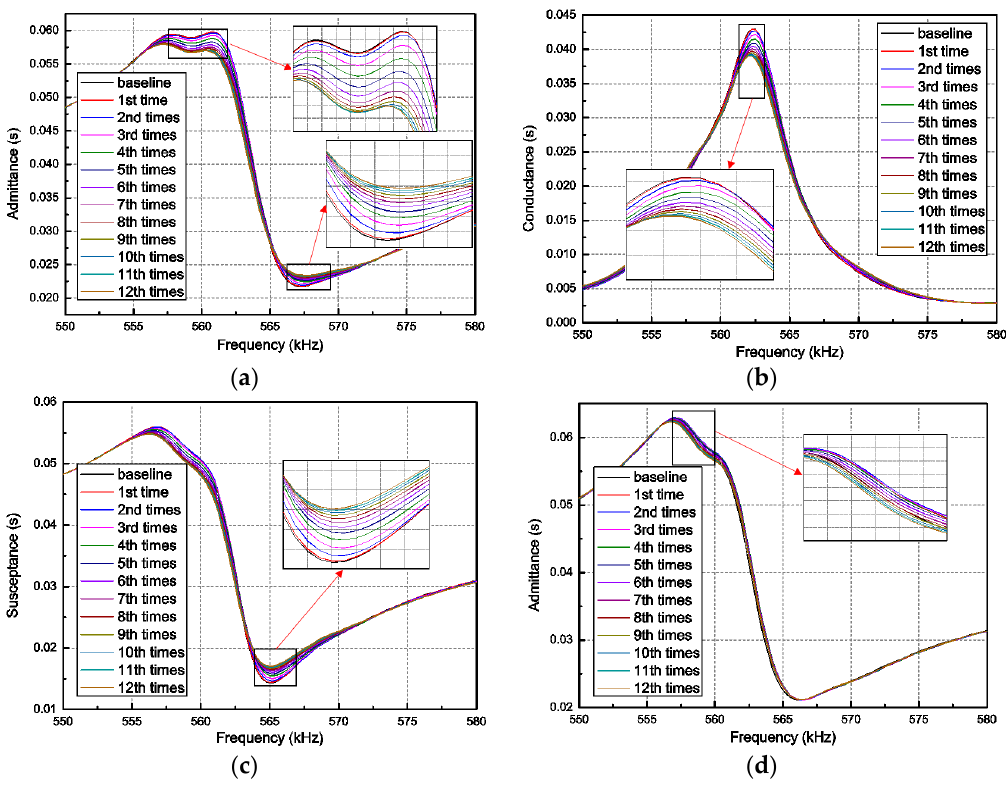
Figure 6. Admittance signatures in different impact load case: ( a ) Admittance of PZT-F; ( b ) conductance of PZT-F; ( c ) susceptance of PZT-F; and ( d ) admittance of PZT-R.